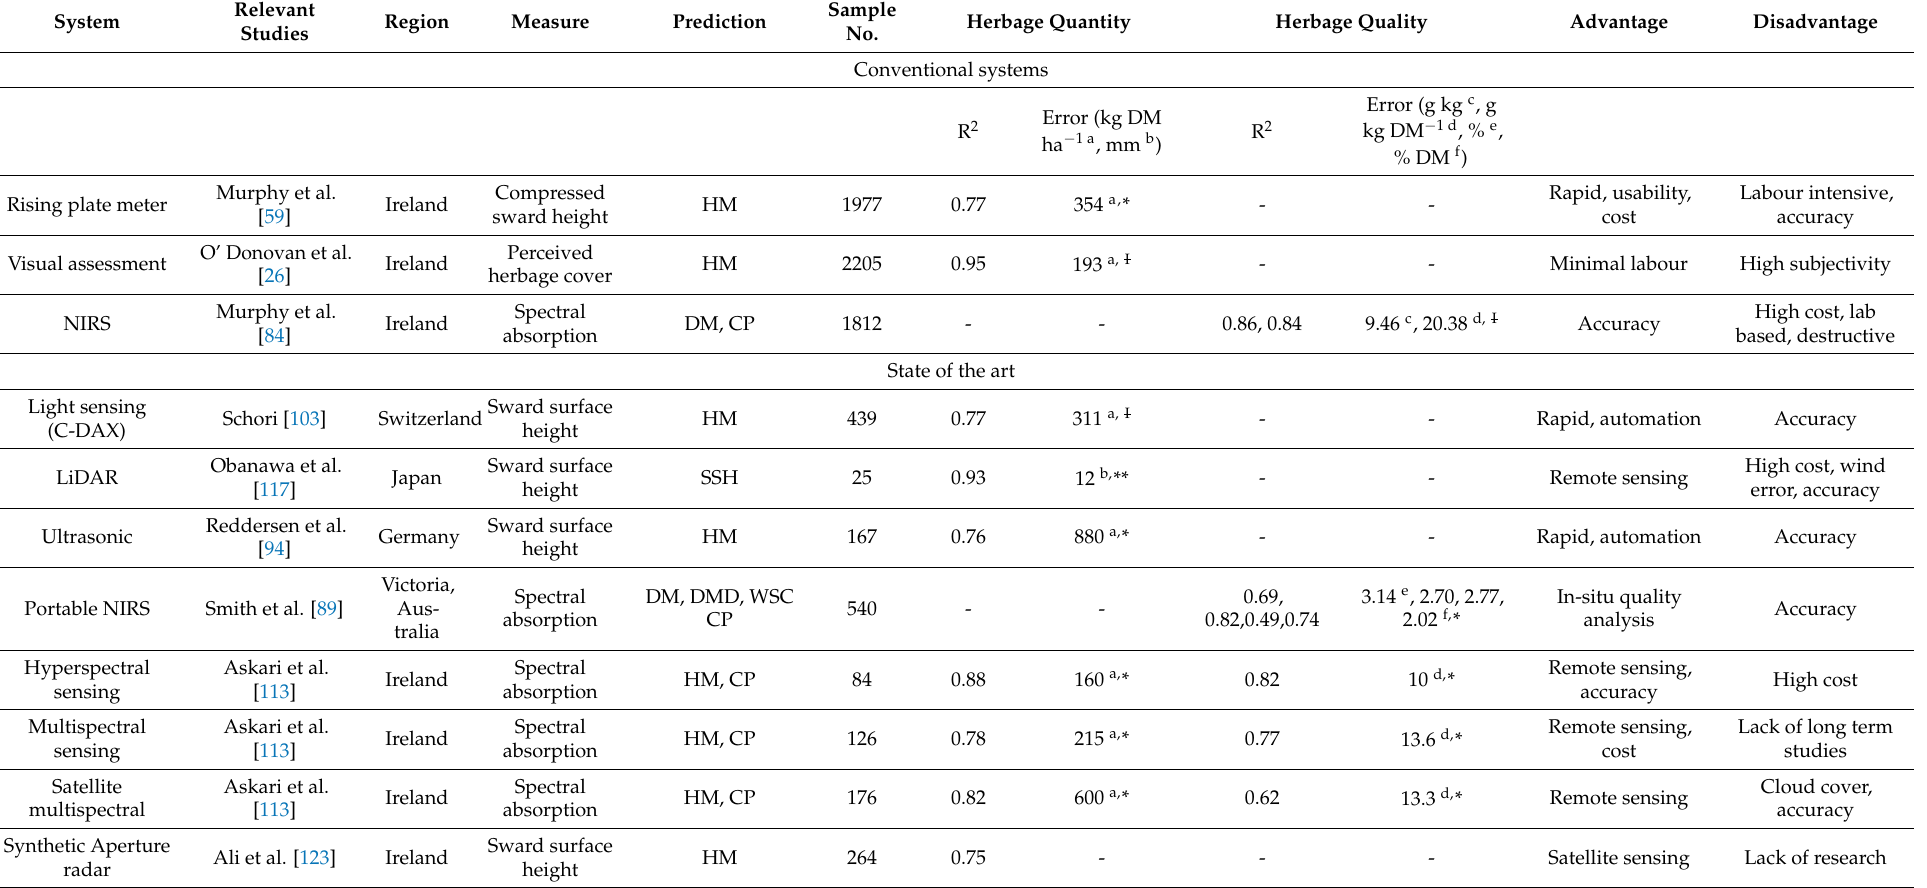
Table 3. Summary of grass measurement systems from the research discussed in this review that were most relevant to temperate (Irish) grasslands.